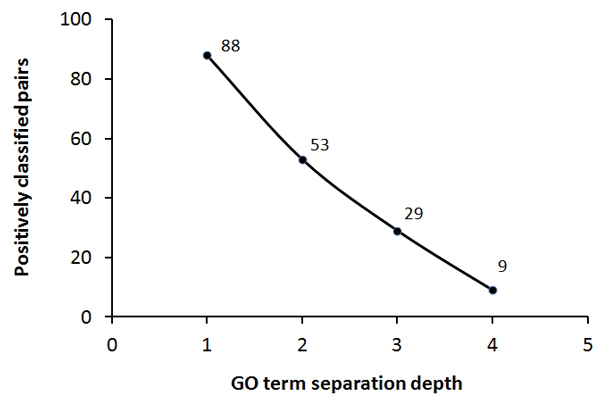
Classification specificity plot.